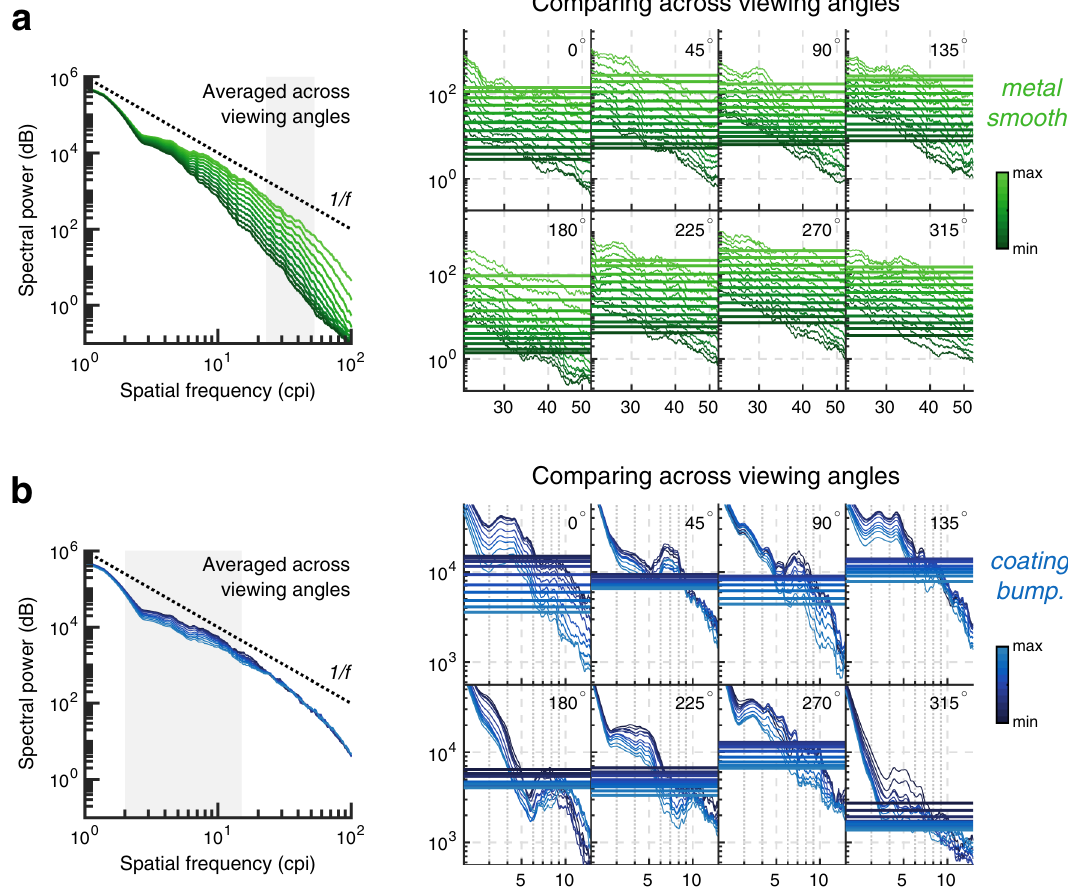
Figure 2. Spectral analysis of the stimuli used for conjoint measurement. Power spectra are shown for varying levels of ( a ) metal smoothness (green scale bar) and ( b ) coating bumpiness (blue scale bar) of the stimuli, interpolated onto a one-dimensional scale of radial frequency. Left: Spectra have been averaged across all eight viewing angles of the objects. Right: The power spectra for each individual viewing angle are shown separately, over the region shaded in grey in the left-hand plots. The mean power over the range shown is given by a horizontal